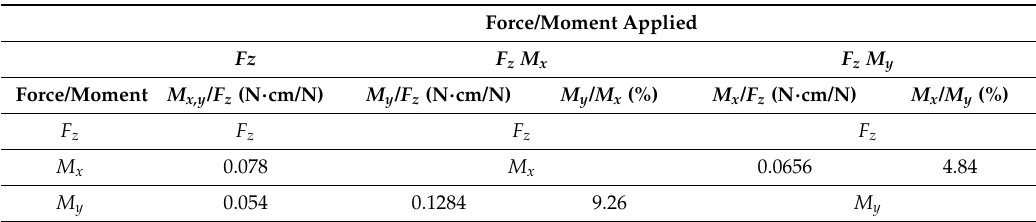
Table 4. Sensor performance property: